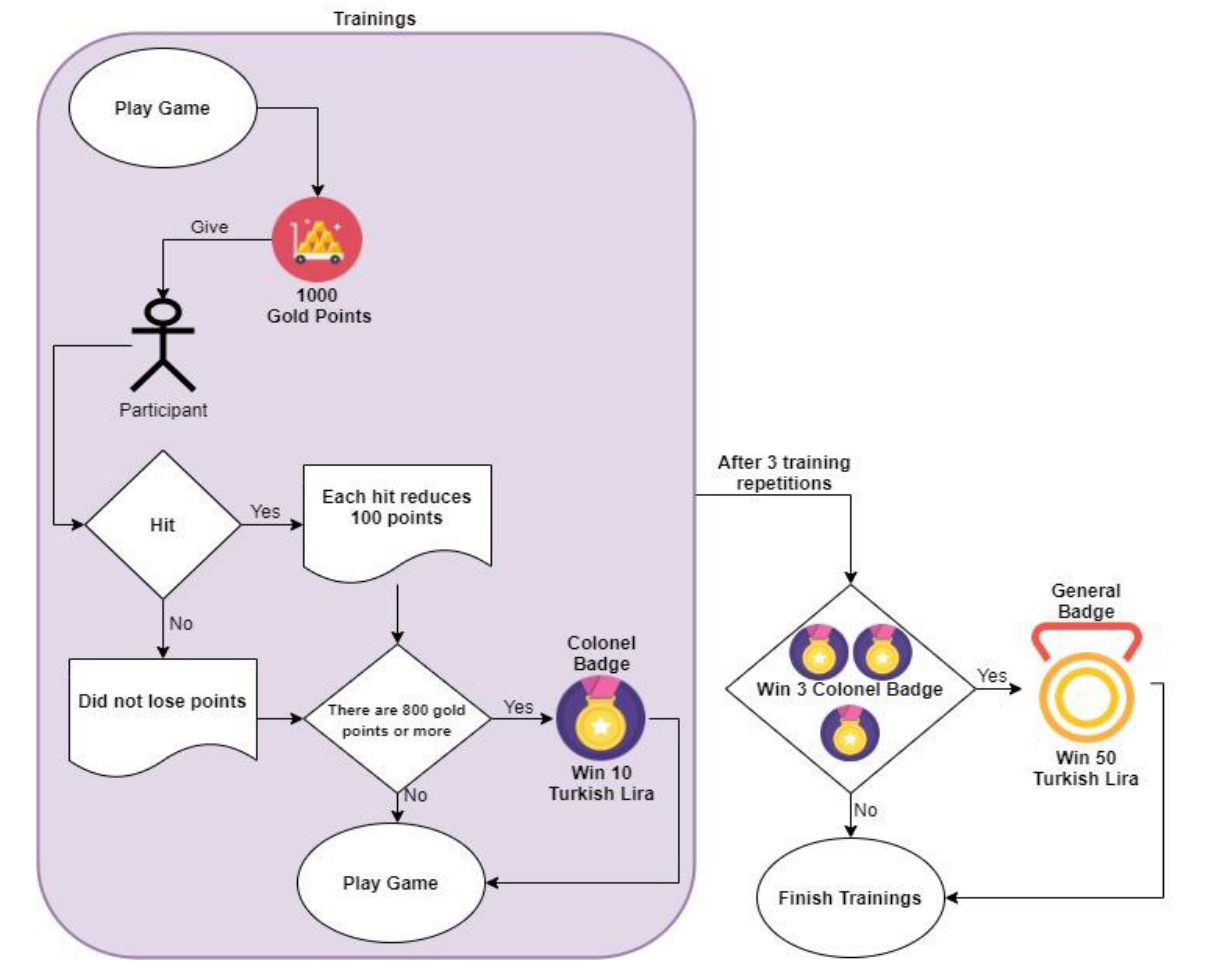
Figure 3. Game flow and game score relationship flowchart.